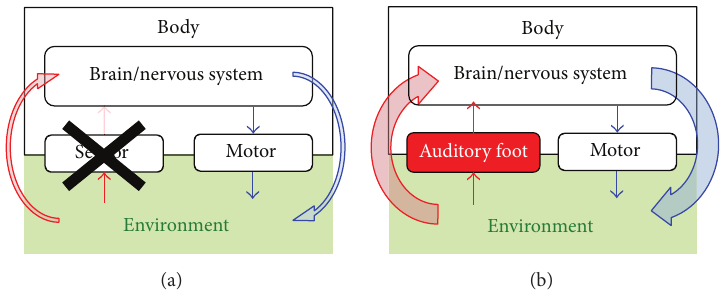
Figure 1: Schematic of the proposed rehabilitation for sensory impairments: (a) from the viewpoint of system engineering, sensory impairments are considered as input failure in a system, leading to dysfunction of the entire system. (b) The dysfunction can be corrected through repair or replacement by another input component, where enhancement of kinesthetic feedback or replacement with another sensory modality allows intervention for the dysfunction through reestablishment of motor-sensory